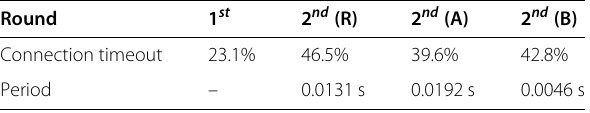
Table 4 Comparison of the probabilities of causing connection timeout and the execution time of the whole test Round 1 st 2 nd (R) 2 nd (A) 2 nd (B) Connection timeout 23.1% 46.5% Period